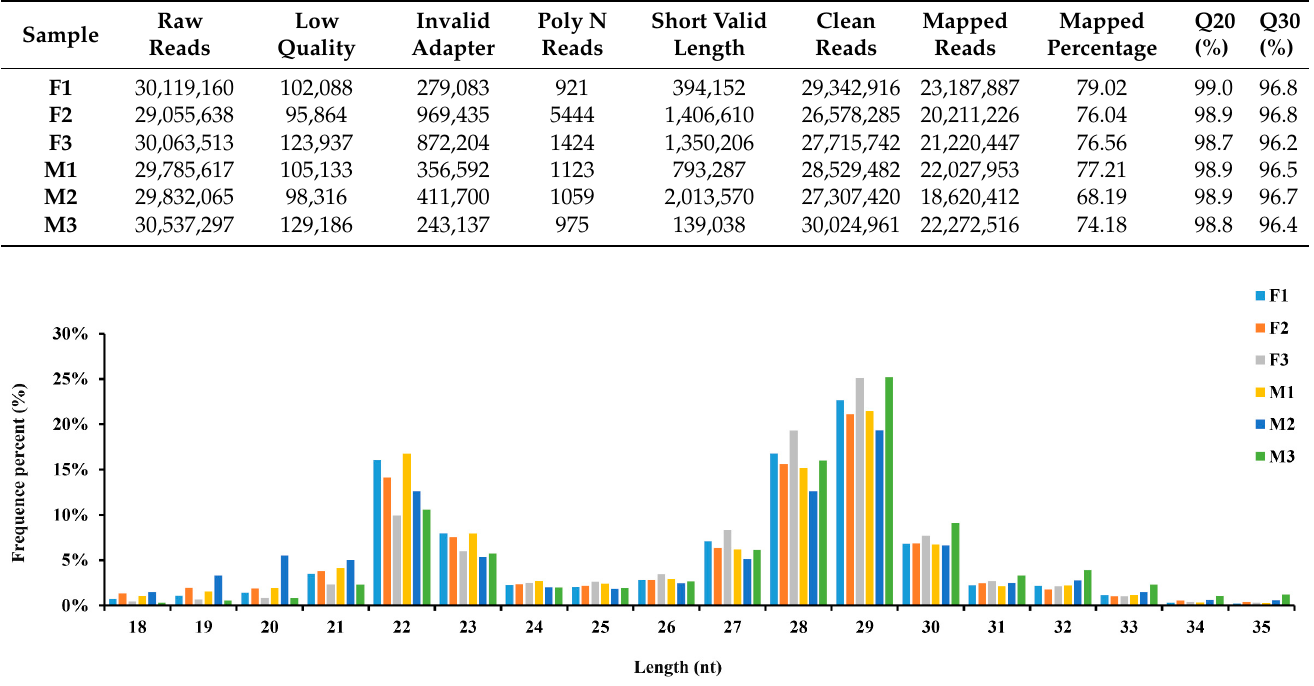
Figure 1. Length distribution of small RNA sequences from the ovary and testis libraries of C. farreri .